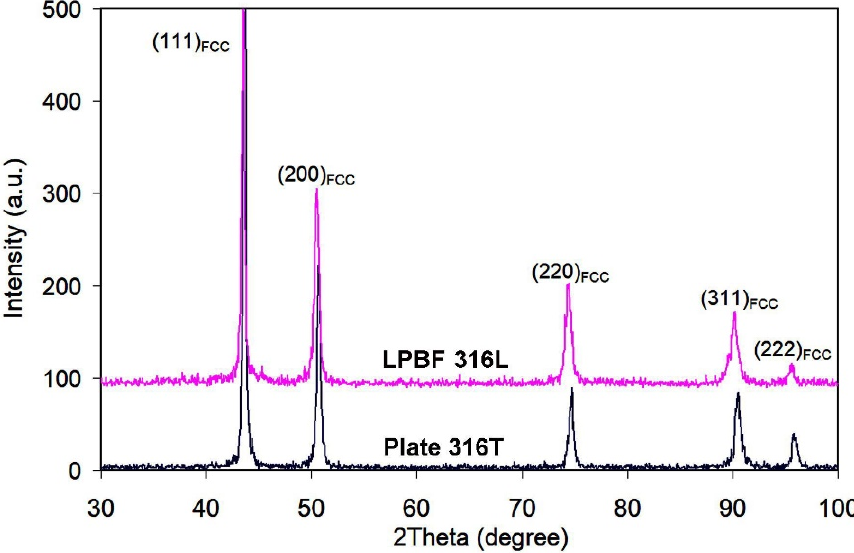
Figure 4. XRD patterns of as-received LPBF 316L and plate 316T specimens.